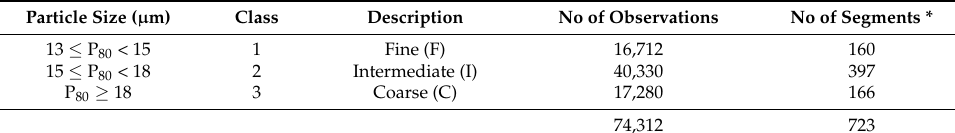
Figure 11. Distribution of particle size classes as a function of scaled temperature and power measurements. Table 2. Distribution of P 80 particle size classes in the IsaMill.